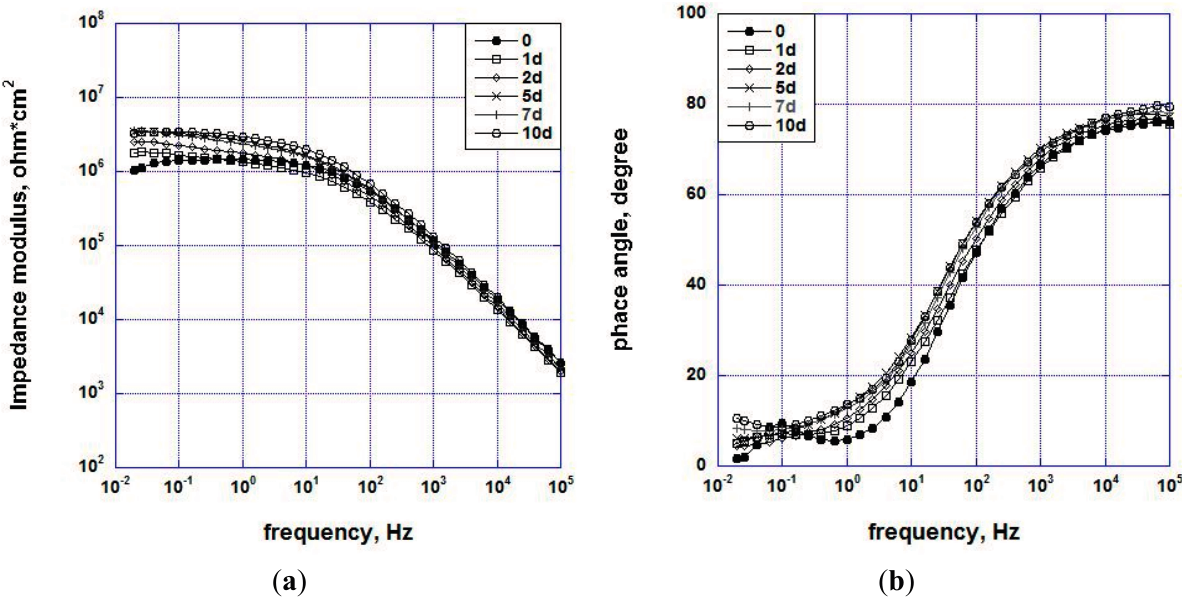
Figure 5. Bode plots for impedance modulus ( a ) and phase angle for sample coated with graphene/epoxy resin ( b ).